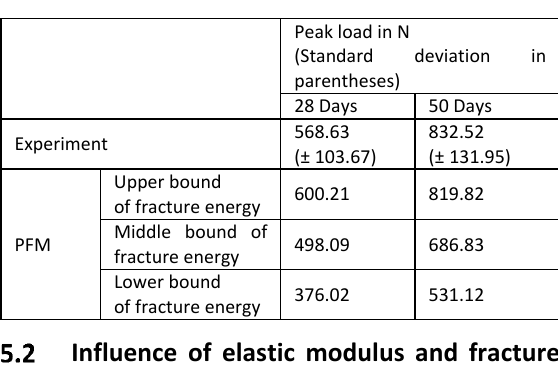
Table 2. Comparison of peak load from pull ‐ off test experiments and PFM.